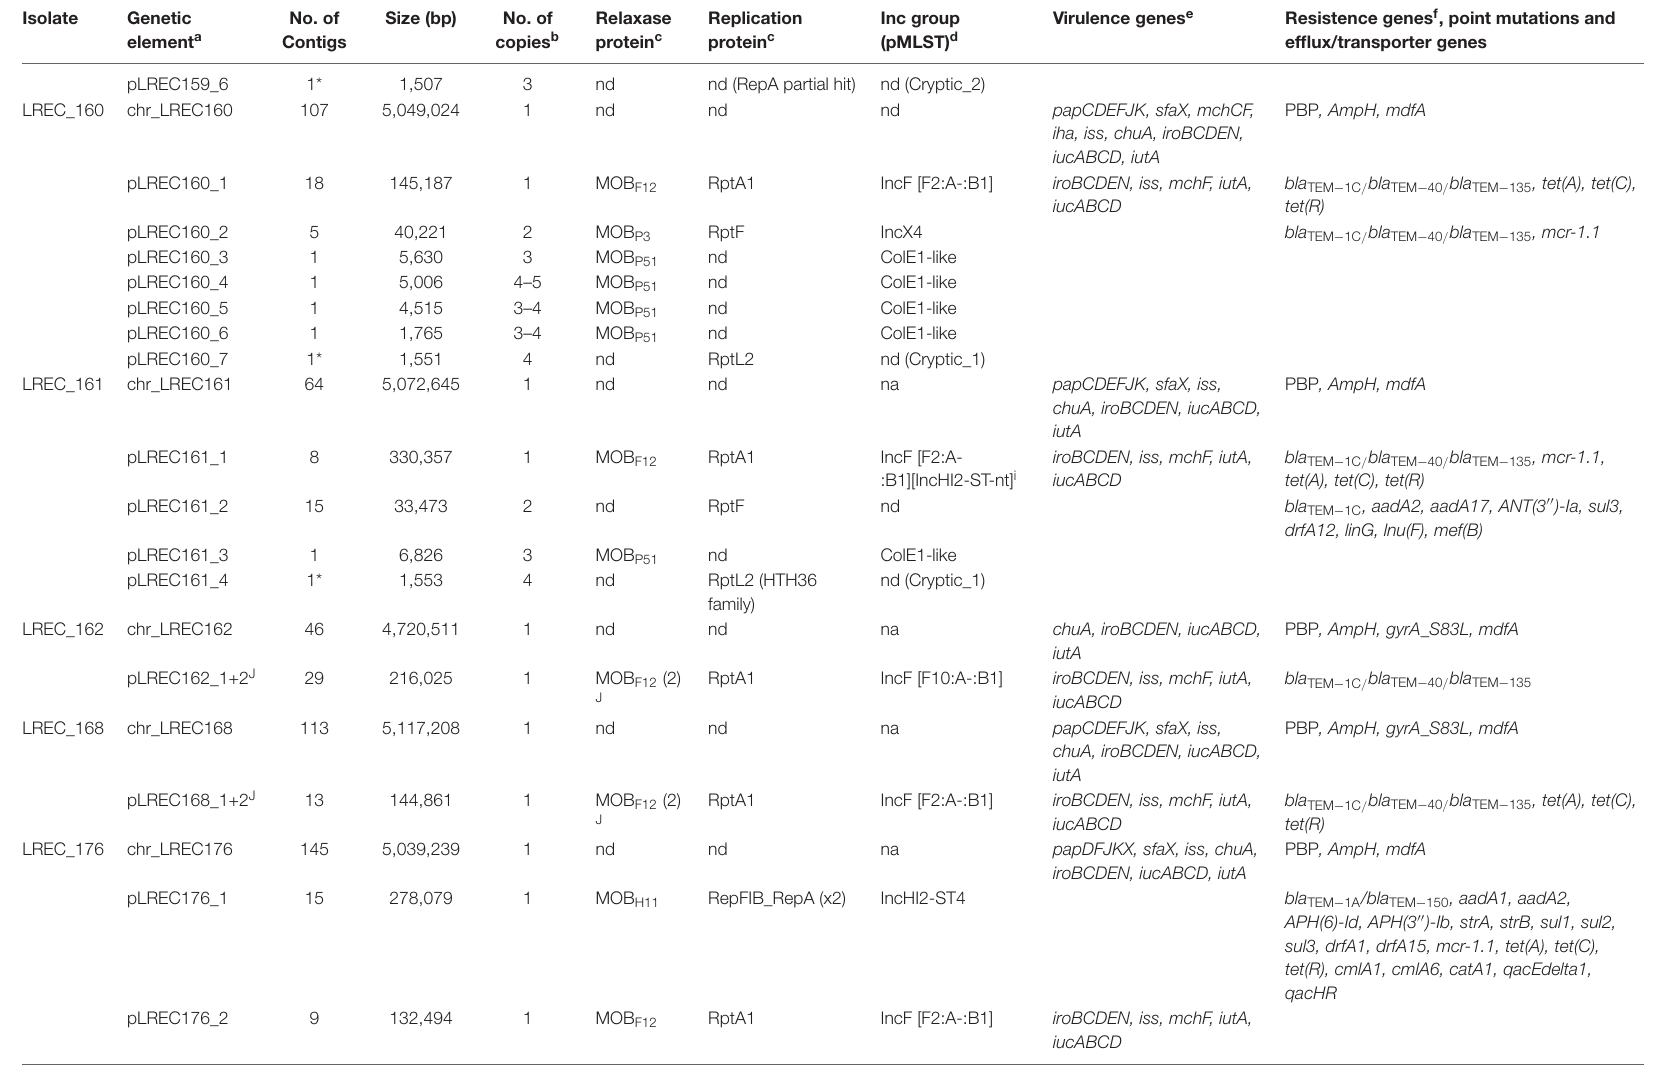
IncF [F2:A-:B1] iroBCDEN, iss, mchF, iutA, iucABCD a Chr, chromosome; p, plasmid. b Approximative number of plasmid copies based on sequencing coverage identified by PLACNET. c Relaxase and replication proteins were identified by the use of PLACNET databases. d Incompatibility groups were determined according to the PBRT scheme and pMLST subtypes according to the allele scheme in http://pubmlst.org/plasmid/. e Virulence genes were detected through VirulenceFinder and VFDB databases (minimum coverage of 90%, minimum identity of 75%); all genomes presented in their chromosome the following genes: aslA, cheBWY, chuSTUVWXY, csgBDEFG, entABCEFS, fdeC, fepABCDG, fes, fimABCDEFGHI, flgG, flhAC, fliGIMP, fyuA, gad, gspCDEFGHIJKLM, ibeA, irp1, irp2, kpsDM, OmpA, yagVWXYZ/ecpEDCBA, ybtAEPQSTUX, ykgK/ecpR. f Antimicrobial resistance genes were detected by using ARG-ANNOT, CARD and ResFinder databases (minimum coverage of 93%, minimum identity of 75%); all genomes presented in their chromosome the following genes (efflux pumps and transport modulators): acrAEFS, bacRS, cpxA, CRP, emrABEKRY, eptA, evgAS, gadWX, H-NS, kdpE, marA, mdtABCEFGHKNOP, msbA, pmrF, tolC, ugd, yojI. g na, not-applicable; h nd, not detected. i Cointegrated plasmid. j Two plasmids that could not be separated (two MOB F12 ) .*Closed